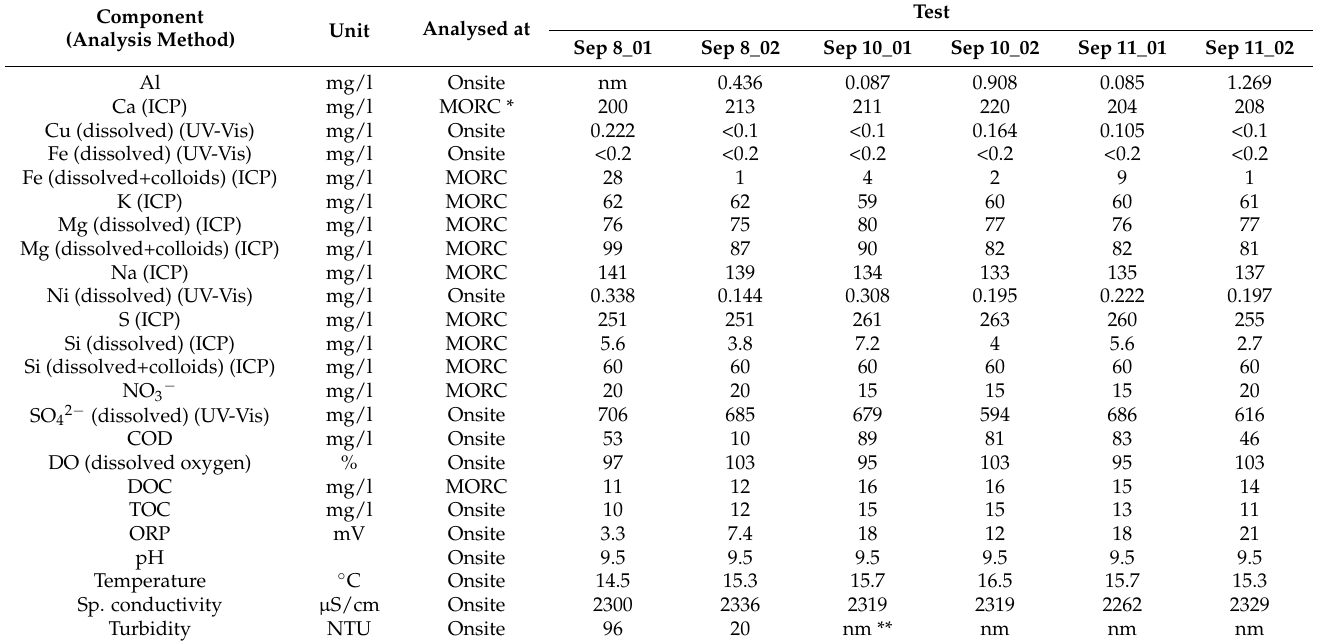
Table 3. Process water sample composition before (01) and after (02) DAF